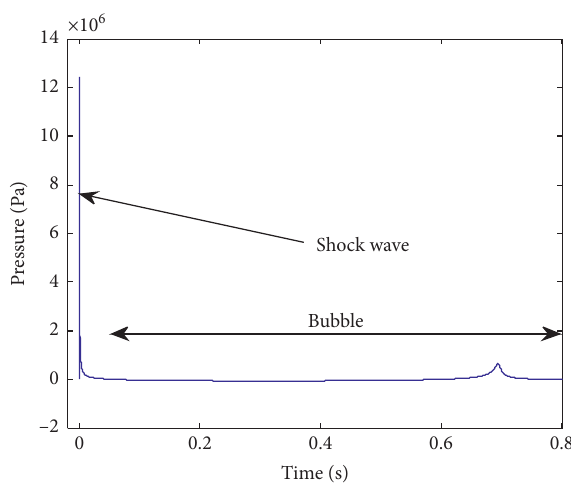
Figure 1: Time history curve of underwater explosion